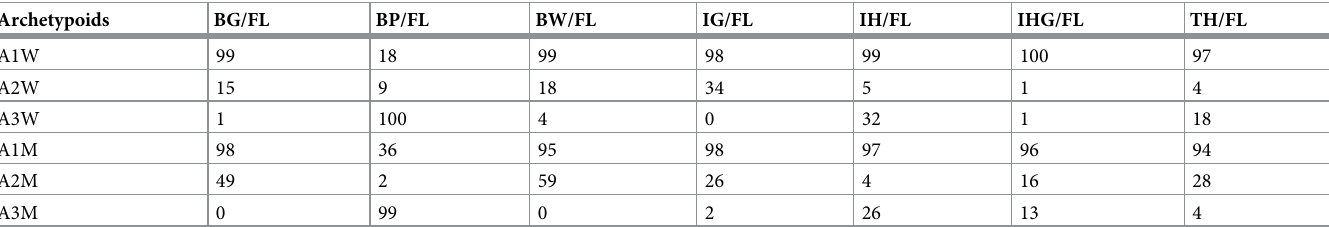
The first three archetypoids correspond to the sample of women. They are denoted by A1W, A2W and A3W. The last three archetypoids correspond to the sample of men. They are denoted by A1M, A2M and A3M. See details in the text about the meaning of the